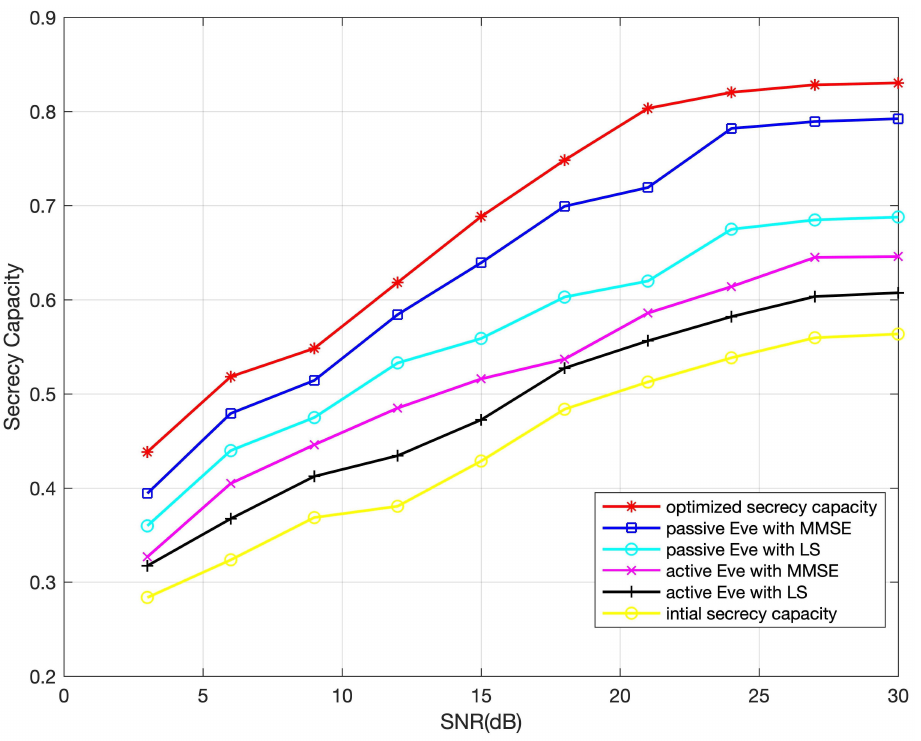
Figure 6. SCO − AN’s Secrecy Capacity Before and After Power Allocation versus Different SNR and Channel Estimation Algorithm with and without active eavesdropper.